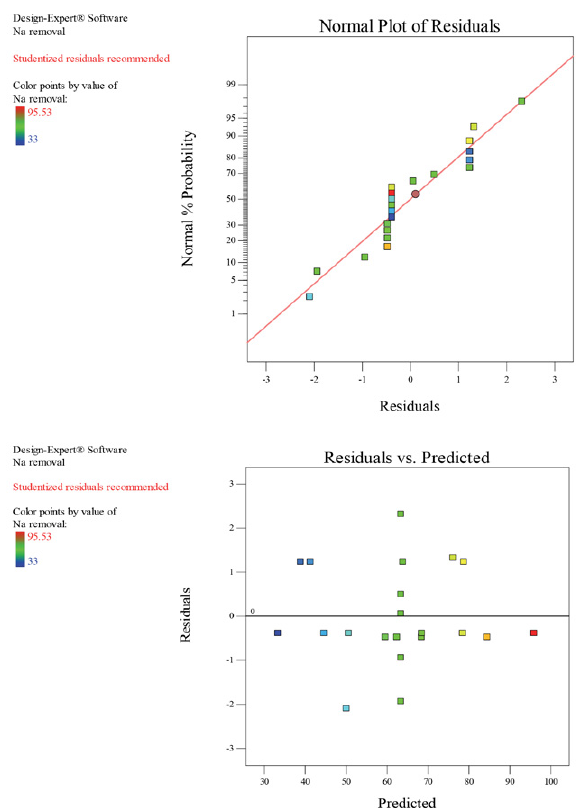
Figure 7. The normality of primary data and